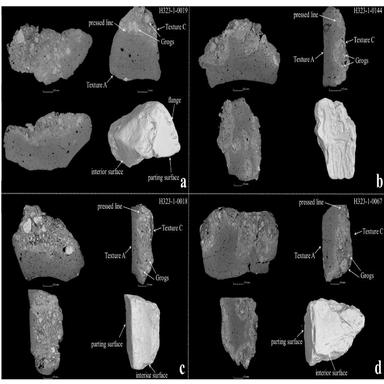
Three-view and 3D-reconstructed photographs of Type II moulds obtained by the micro-CT scanning.